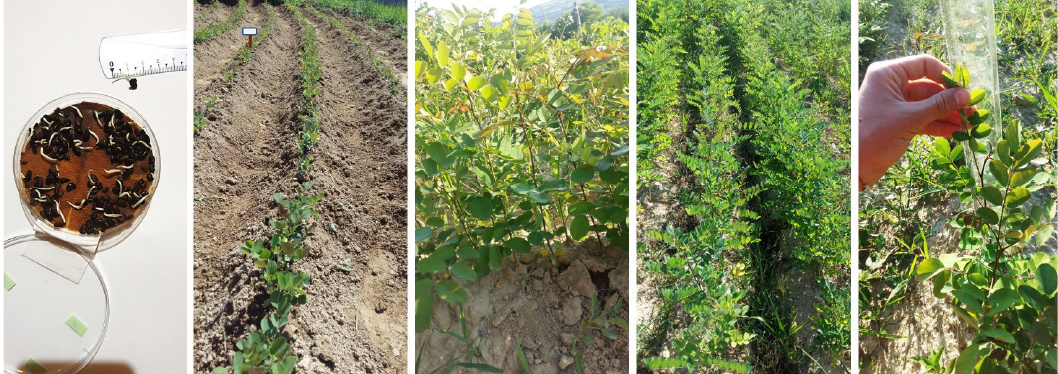
Figure 2. Aspects from the work stages and obtaining black locust seedlings in the field Statistical